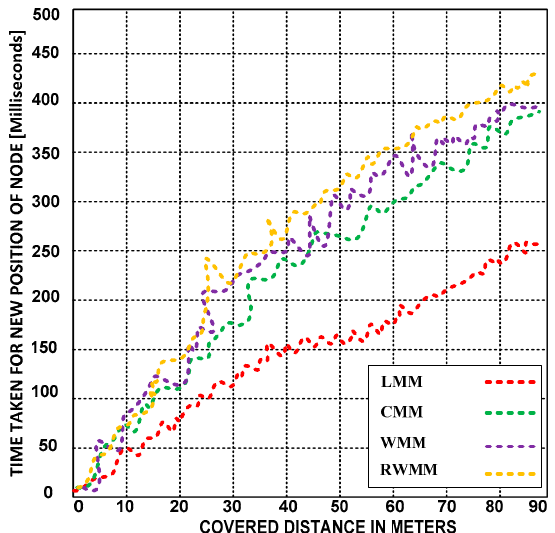
Figure 8. Times taken by the sensor node to reach different positions using the LMM, CMM, RWMM, and WMM at a fixed velocity of 10 m/s.